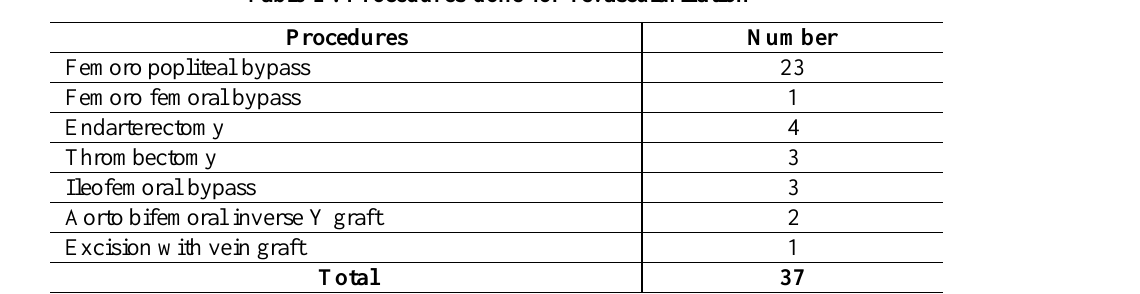
Table I : Procedures done for revascularization